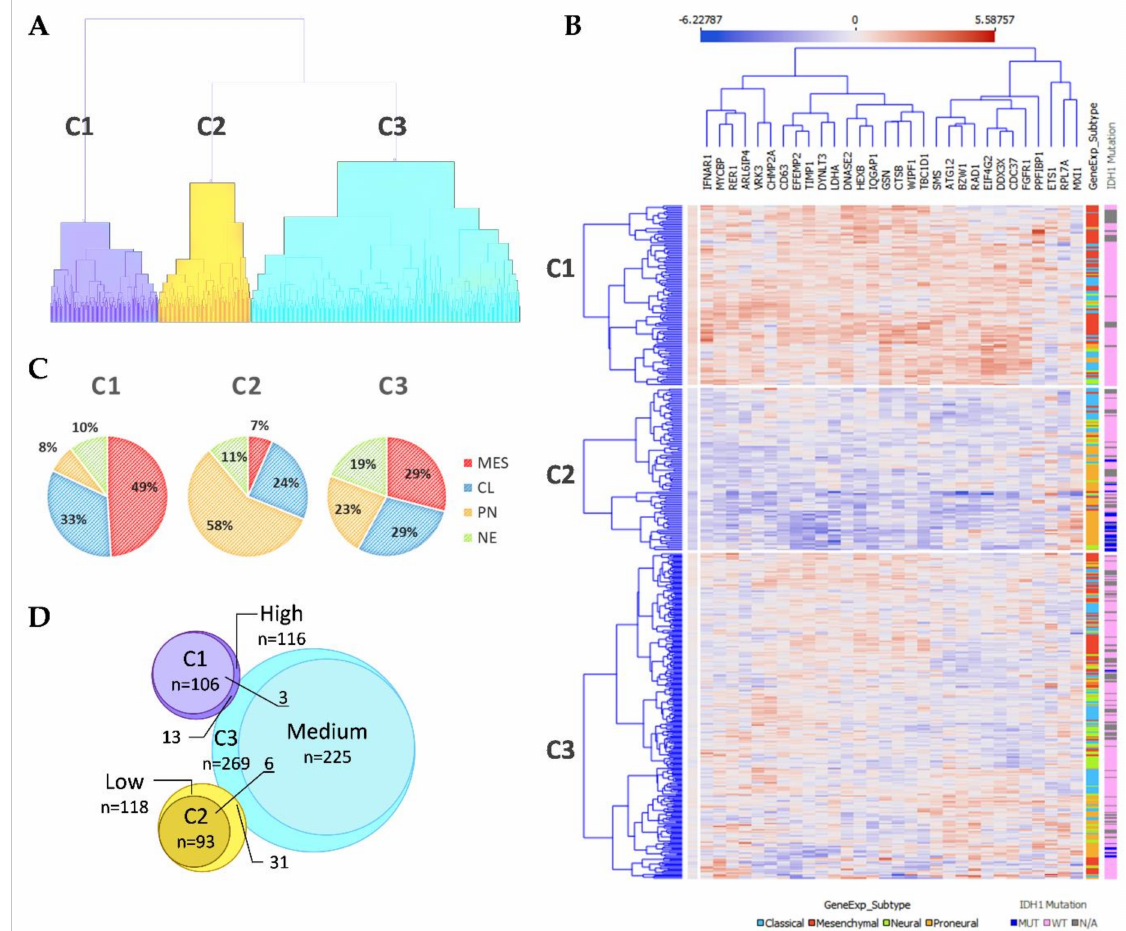
Figure 2. ( A ) Unsupervised hierarchal clustering of screened GSC signature genes applying TCGA GBM specimens generated three clusters. C1–3—Cluster 1–3. ( B ) Heatmap of TCGA GBM specimens using 30 GSC specific genes. Samples grouped according to cluster dependency. Penultimate column indicates GBM subtype: light blue color—Classical; red color—Mesenchymal; green color—Neural; orange color—Proneural. The last column indicates IDH1 mutation status: dark blue color—Mutant case; pink—Wild type case; grey color—no data available. ( C ) GBM subtypes composition at the clusters. ( D ) Venn diagram of Clusters and average expression of selected 30 genes groups (grouped in low, medium, and high expression groups according first (Q1) and third (Q3) quantiles) specimens